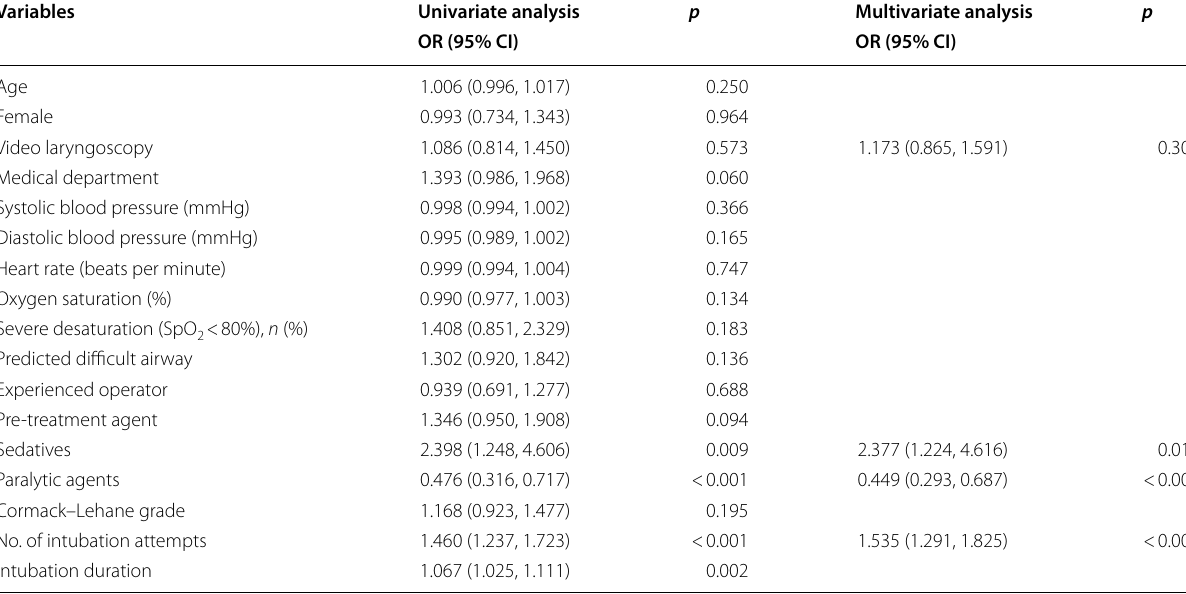
OR odds ratio, CI confidence interval